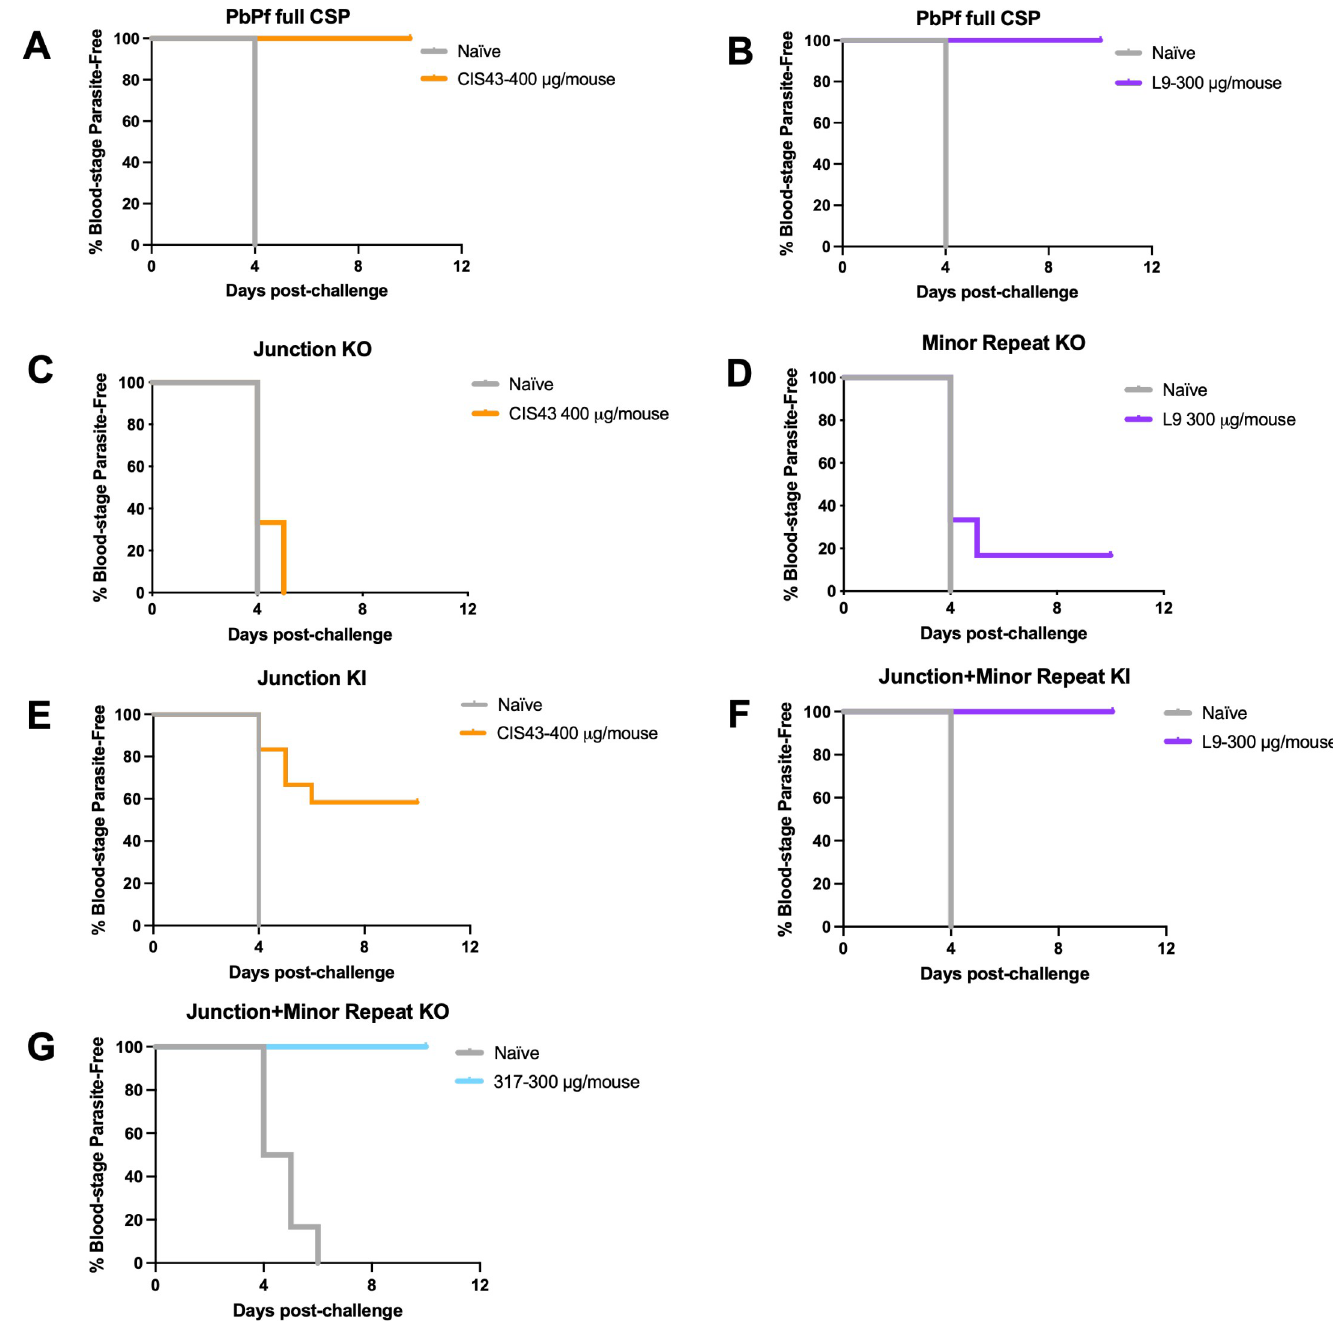
Fig 5. PfCSP mAb-mediated sterile protection in mice bitten by mosquitoes infected with transgenic SPZ lines. Kaplan-Meier survival curves of C57BL/6 mice (n = 12/group; combined from two independent experiments) injected with PBS (na ï ve), CIS43 (400 μ g), L9 (300 μ g), or 317 (300 μ g) and challenged 16 hours later with 5 bites from mosquitoes infected with SPZ expressing (A-B) PbPf full CSP, (C) Junction KO, D) Minor Repeat KO, E) Junction KI, (F) Junction+ Minor Repeat KI, and G) Junction + Minor repeat KO. There were several notable discrepancies between mAb binding to the transgenic KO/KI SPZ lines in vitro and protection in vivo (Figs 2 vs 4 and 5). For instance, CIS43 and 317 had high binding to JR KO SPZ (lack JR) and JR+MR KI SPZ (lack CR), respectively, but mediated